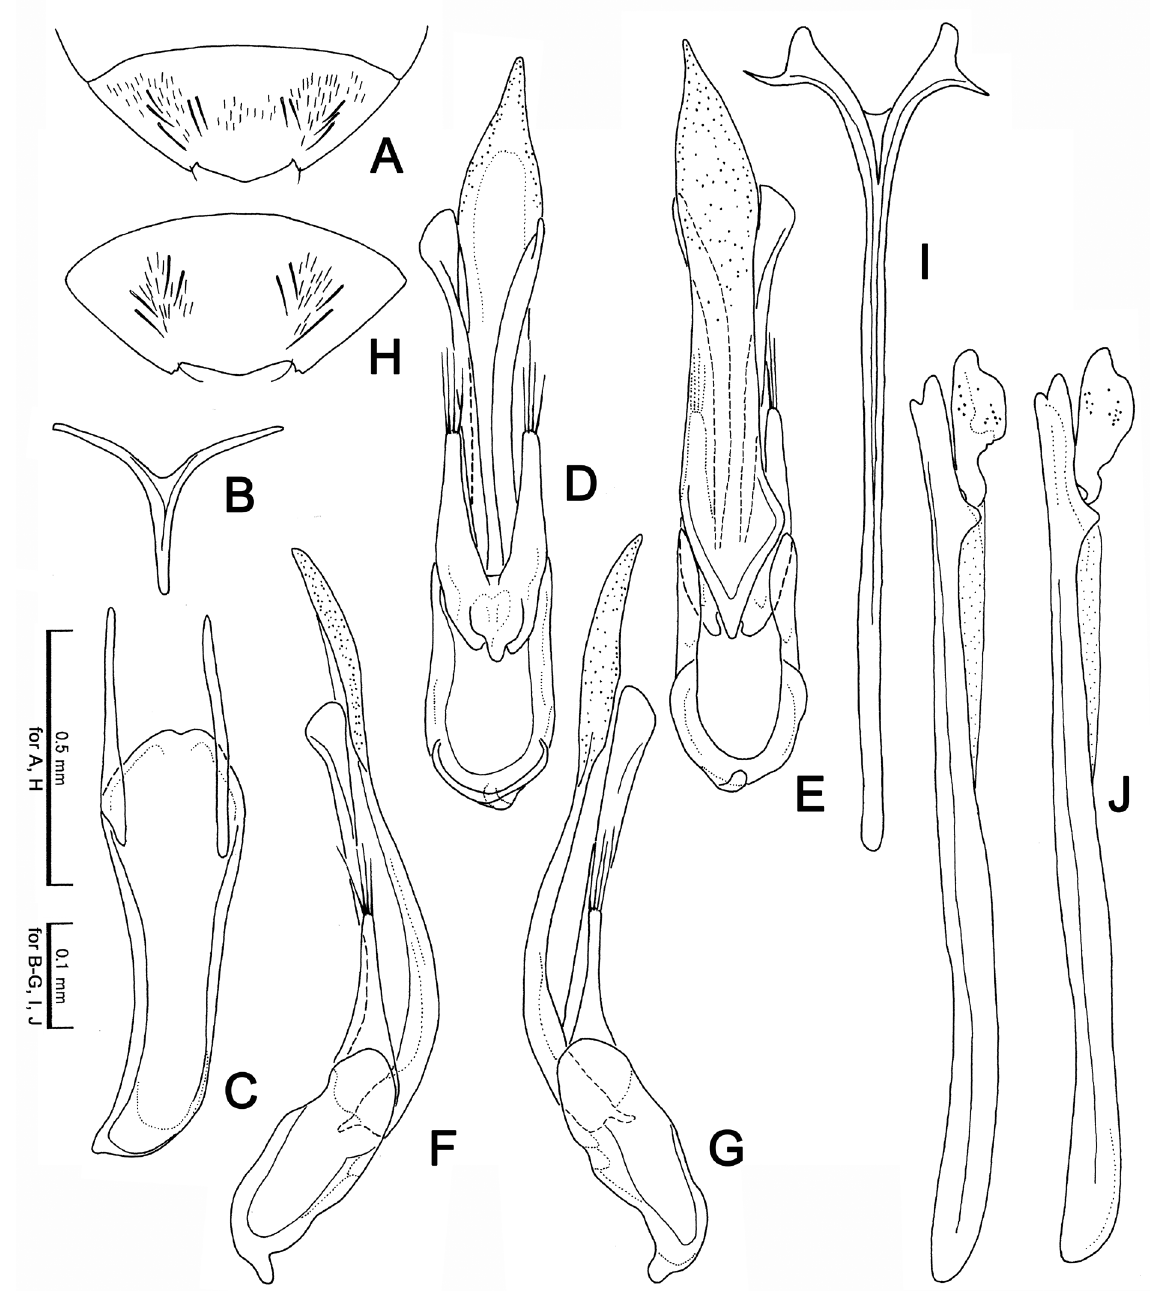
Fig. 15. Mexico palauensis sp. nov., male (A–G) and female (H–J) genitalia (paratypes, EUMJ). A, H . Sternite VII. B . Sternite VIII. C . Sternite IX. D . Aedeagus, ventral view. E . Aedeagus in dorsal view. F . Aedeagus in right lateral view. G . Aedeagus, left lateral view. I . Urosternite. J